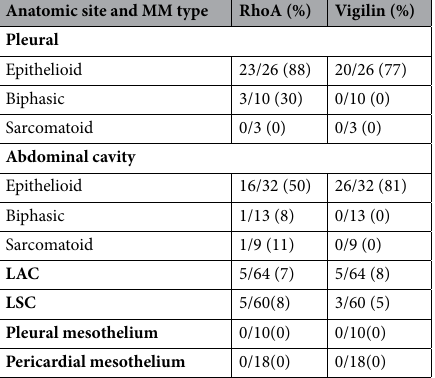
Table 2. Positivity rate of RhoA and vigilin as revealed by immunohistochemistry of malignant mesothelioma (MM). LAC, lung adenocarcinoma, LSC, lung squamous cell carcinoma.